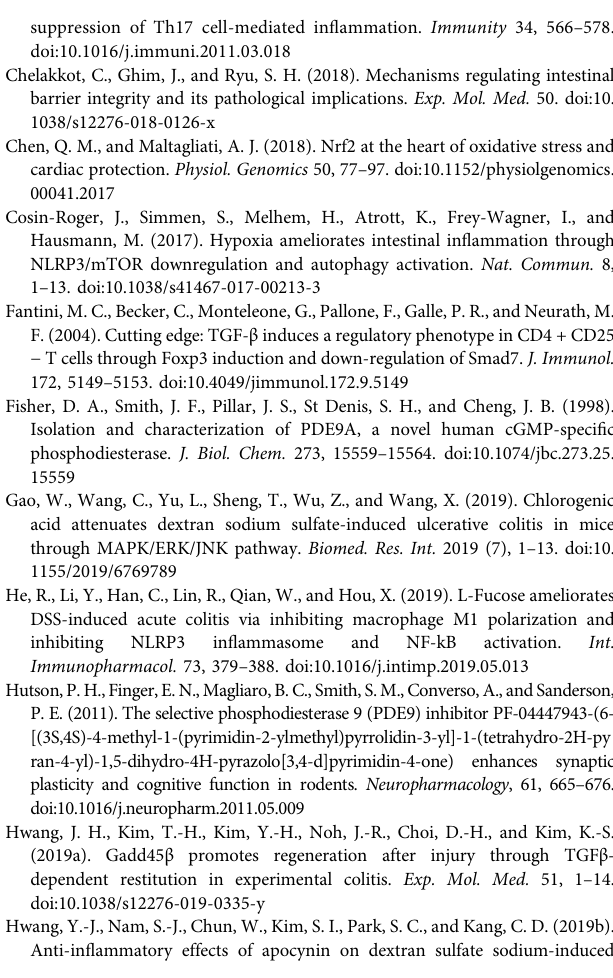
FIGURE S1 :ThemRNAexpression ofPDEsuperfamilyinthecolonofDSSinduced UC model in female C57 mice (10 weeks). Data are presented as mean ± standard error mean (SEM) (n=3). FIGURE S2 : PF-04447943 suppressed in fl ammation suppressing STAT3 and upregulated Foxp3 expression in spleen. (A) Expression of p-STAT3 (Y705), SOC3, Foxp3, and GAPDH in spleen determined by western blot. (B) Relative expression of p-STAT3 (Y705), SOC3, and Foxp3, respectively. Data are presented as mean ± standard error mean (SEM) (n=2). Here, *** p < 0.001, ** p < 0.01, * p < 0.05 vs . control group and ### p < 0.001, ## p < 0.01, # p < 0.05 vs . DSS-treated